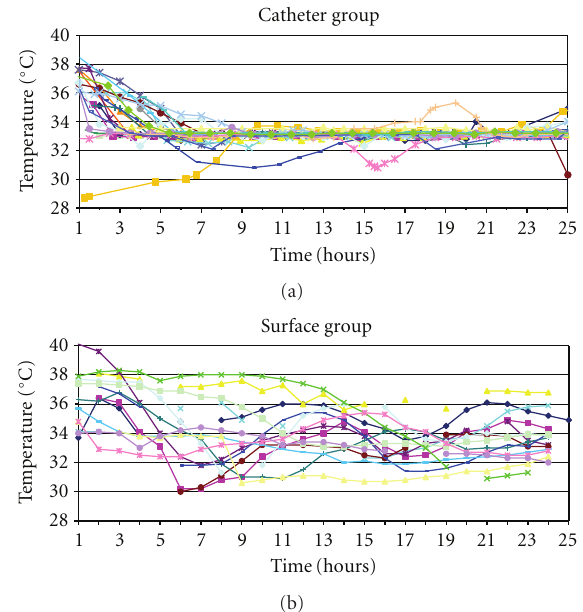
Figure 1: Hourly bladder temperature recordings of each patient from the time point that the cooling protocol was initiated to the end of active cooling (24 hours). (a) Endovascular-cooled group ( n = 26). (b) Surface-cooled group ( n =